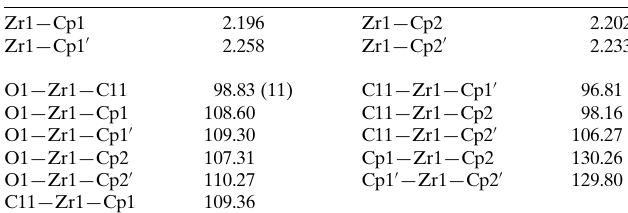
Table 1 Selected geometric parameters (A˚ , (cid:2) ).